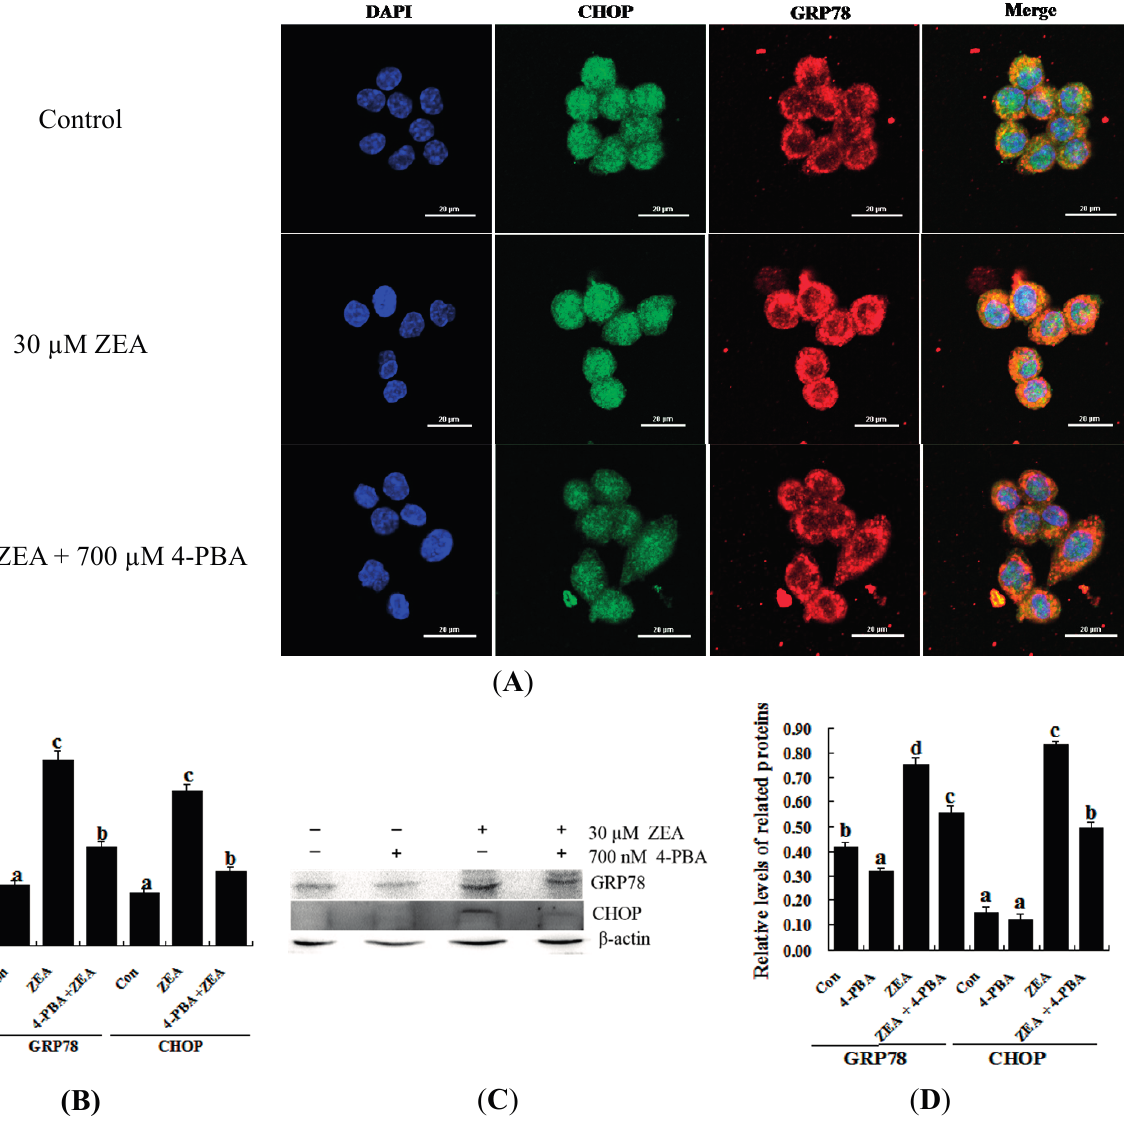
Figure 4. Effect of 4-PBA on the levels of GRP78 and CHOP in ZEA-treated RAW 264.7 macrophages. RAW 264.7 macrophages were treated 24 h with 30 µM ZEA or 30 µM ZEA with 700 nM 4-PBA. ( A , B ) Confocal immunofluorescence photomicrography showed the expression of CHOP protein (green fluorescence) and GRP78 protein (red fluorescence) in the control (the upper panels), ZEA (the center panels) or ZEA + 4-PBA cells (the bottom panels). Bars = 20 µm; ( C , D ) Western blot analysis of GRP78 and CHOP in ZEA-treated RAW 264.7 macrophages. The analyses of the band intensities on films are presented as the relative ratio of GRP78 and CHOP to β -actin. Statistical analysis is shown in the bar graphs. Data are presented as the mean ± SEM of three independent experiments. Bars with different letters are significantly different ( p <